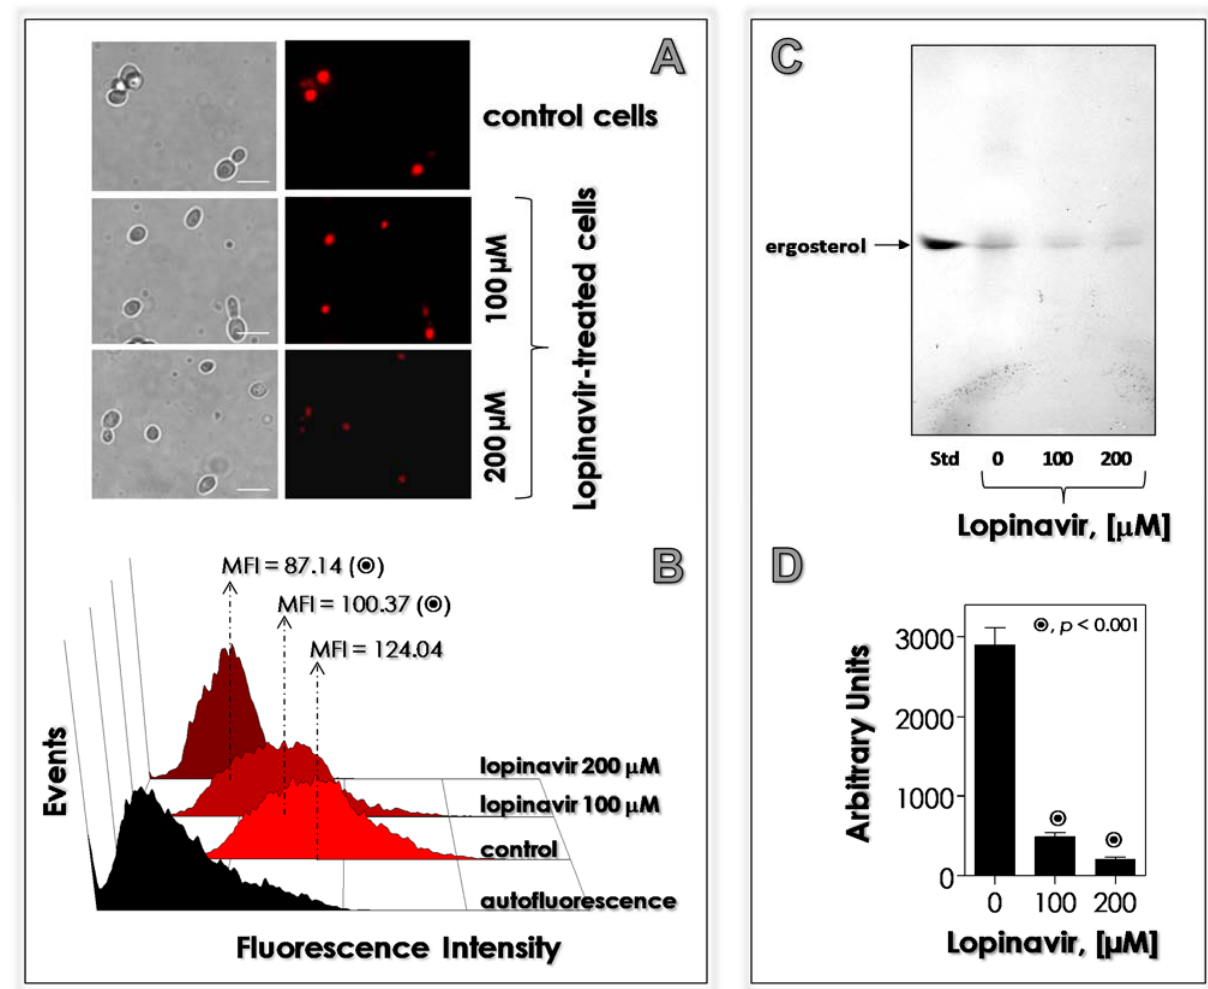
Figure 7. Effect of lopinavir on the production of neutral lipids in C. albicans . In this set of experiments, yeast cells were incubated for 20 h in the absence (0 or control cells) and in the presence of lopinavir at both 100 and 200 µM. After that, yeasts were analyzed to detect neutral lipid inclusions ( A , B ) and ergosterol ( C , D ). ( A ) Differential interference contrast microscopy (left images) and fluorescence microscopy with Nile red (right images) evidenced the intracellular lipid inclusions. ( B ) Flow cytometry assay corroborated the fluorescence microscopy, which showed a drastic reduction in Nile red-positive cells as judged by the drop in the mean of fluorescence intensity (MFI). ( C ) High-performance thin-layer chromatography (HPTLC) showing the ergosterol chemically extracted from the yeast cells as well as the ergosterol standard (Std), which was applied into the same plate. ( D ) Densitometrical analyses of the ergosterol-corresponding bands, expressed in arbitrary units, were shown. The symbols indicate the experimental systems considered statistically significant from the control (Student’s t -test).